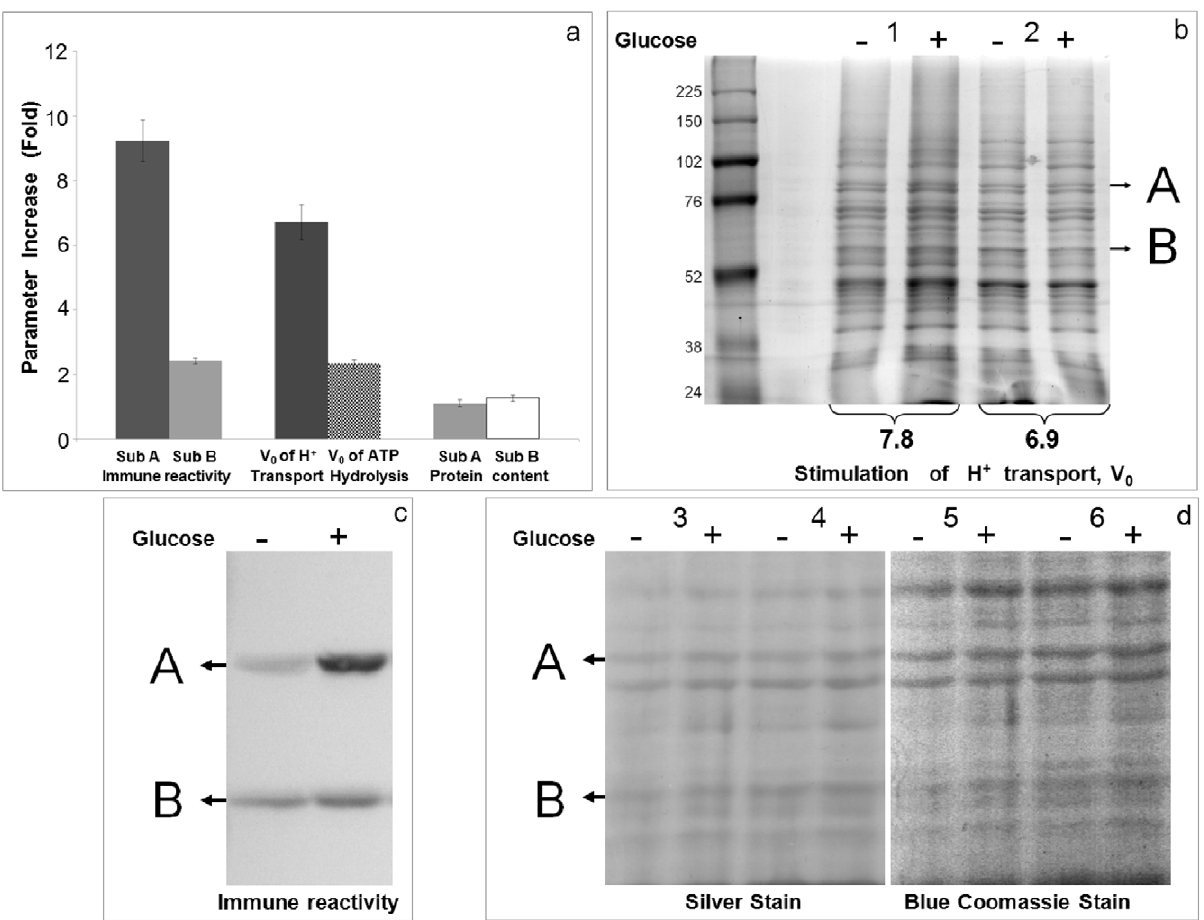
Figure 6. Comparison of properties of the V H + -ATPase activated and non-activated by extracellular glucose. ( a ) Extracellular glucose causes asymmetrical increase in the immune reactivity of subunits A and B as well as in the initial velocities of H + transport and ATP hydrolysis. The protein content of these subunits was not changed in contradiction with the mechanistic model prediction (Fig. 1, step A). ( b ) Protein profiles of TM isolated from the spheroplasts pre-incubated with and without 100 mM extracellular glucose. The proteins were solubilised with 10% SDS, separated by SDS-PAGE (15 m g/each well; see Methods) and stained with Coomassie blue. The representative data from five independent isolations of TM are shown. The Arabic numbers indicate the stimulation degree of the initial velocities of H + transport for each experiment. ( c ) Immunoblot of activated and non-activated enzyme; the amount of 30 m g and 15 m g of protein were loaded onto the wells corresponding to ( 2 ) and ( + ) glucose, respectively. ( d ) After SDS-PAGE, the protein bands were firstly visualised with Coomassie blue and, after gel destaining, were secondly detected by silver stain. Protein content loaded onto the wells 3 2 ;3 + ;4 2 and 4 + (=5 2 ;5 + and 6 2 ;6 + ) was 7, 11, 13 and 15 m g, respectively. A merger of the Coomasie-stained gel and immunoblot was used to localise the bands corresponding to the subunits A and B in each experiment (not shown). One representative experiment of five independent membrane isolations is shown.